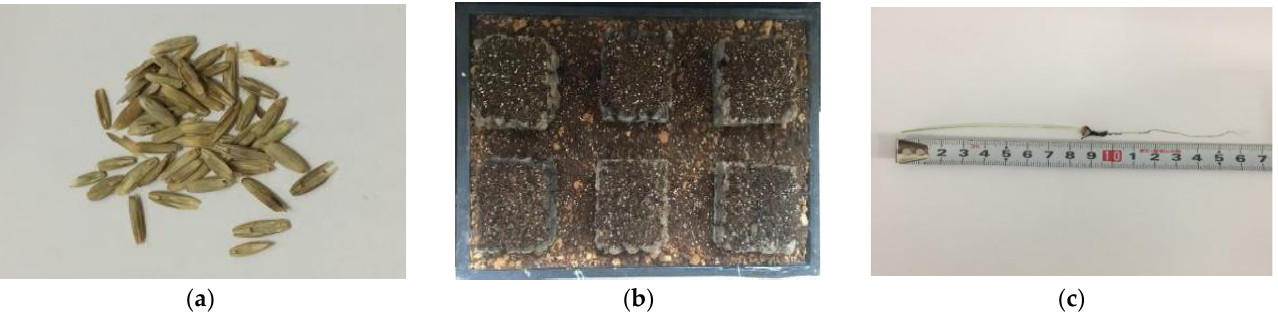
Figure 3. Planting experiment. ( a ) Tall fescue seeds; ( b ) Surface planting structures; ( c ) The measurement of root length. ment of root